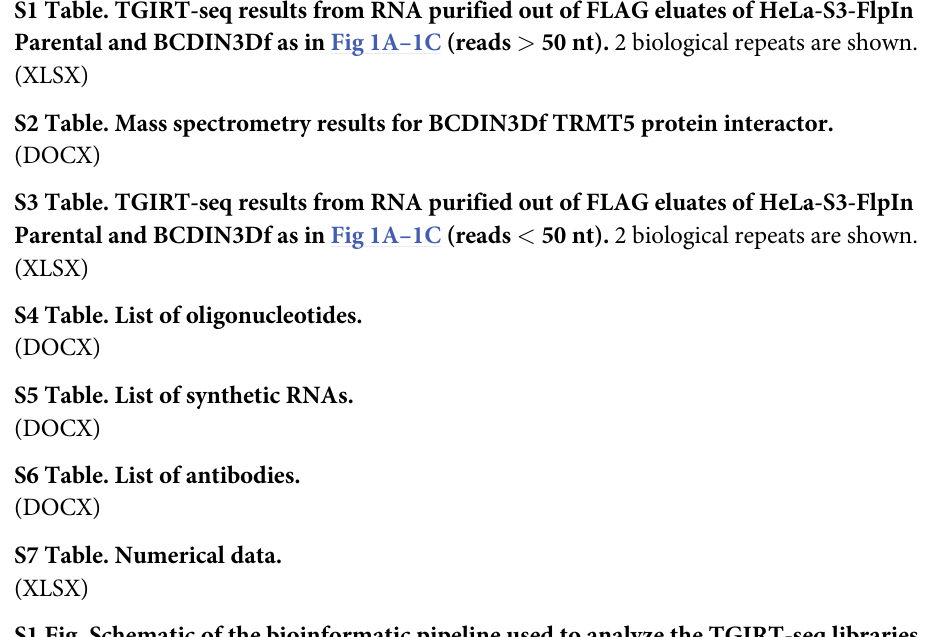
S1 Table. TGIRT-seq results from RNA purified out of FLAG eluates of HeLa-S3-FlpIn